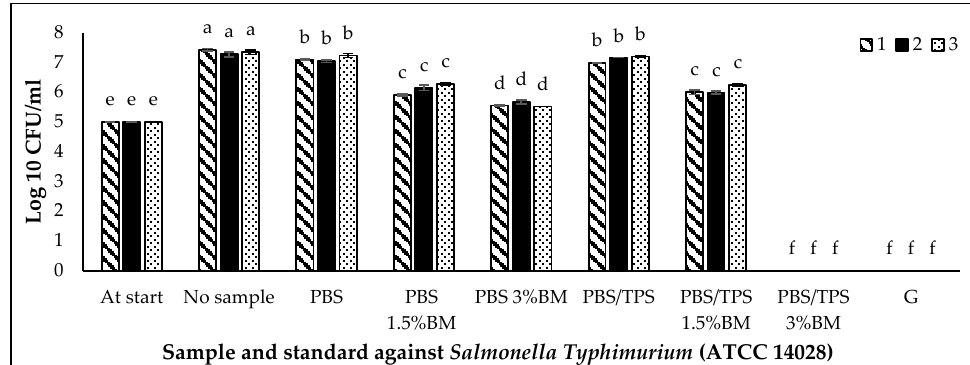
Figure 9. Salmonella Typhimurium (ATCC 14028) growth on different PBS films. Note: At start: the cell number of culture before incubation (5 log CFU/mL); No sample: no PBS film; PBS: PBS film without antimicrobial agent; PBS 1.5% BM: PBS with 1.5% BM; PBS 3% BM: PBS with 3% BM; PBS/TPS: PBS with tapioca starch; PBS/TPS 1.5% BM: PBS/tapioca starch with 1.5% BM; PBS/TPS 3% BM: PBS/tapioca starch with 3% BM; G: Gentamicin. Error bars represent standard deviation (n = 3). The different a–f small letters indicate significant difference ( p < 0.05) among film